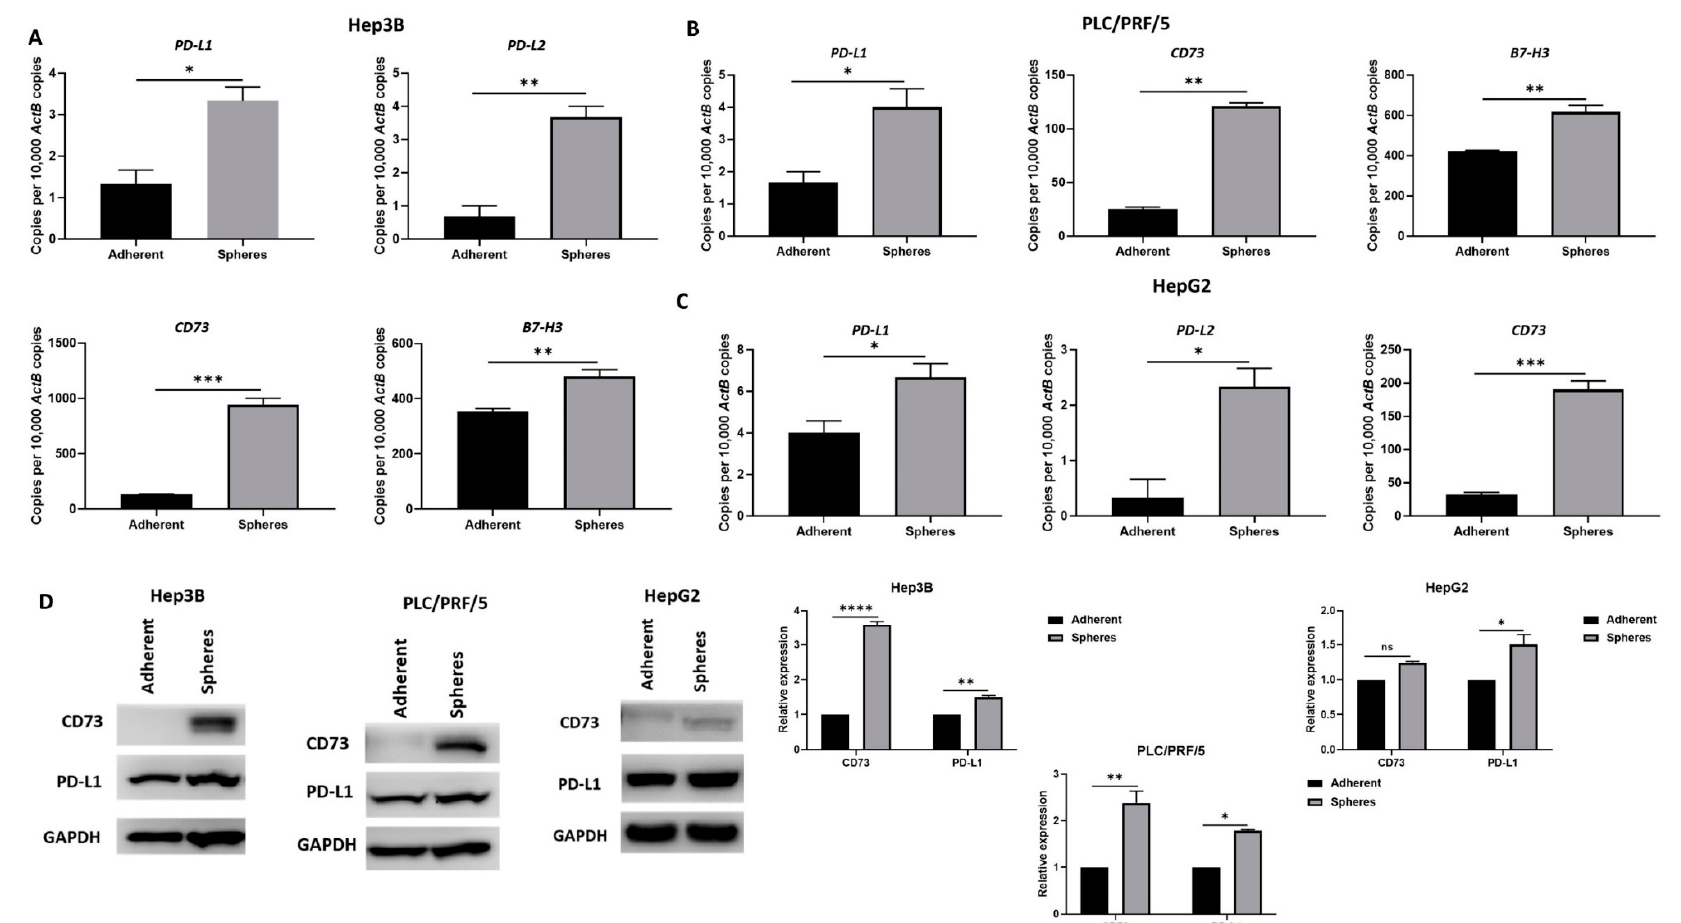
Figure 7. Human HCC-derived spheres overexpress immune checkpoint molecules. ( A ) qRT-PCR demonstrated upregulation of PD-L1, PD-L2, CD73 and B7-H3 in Hep3B-derived spheres compared to adherent cells. ( B ) PLC/PRF/5-derived spheres overexpress PD-L1, CD73 and B7-H3 compared to adherent cells, and ( C ) HepG2-derived spheres exhibited increased expression of PD-L1, PD-L2 and CD73 compared to adherent cells, as revealed by qRT-PCR. ( D ) Western blot analysis demonstrated an increase in CD73 and PD-L1 expression in Hep3B, PLC/PRF/5 and HepG2-derived spheres compared to adherent cells. GAPDH was the loading control. Detailed information about Western Blot can be found at Supplementary Materials. ( n = 3, * p < 0.05, ** p < 0.01, *** p < 0.005, **** p < 0.001, ns: not significant).